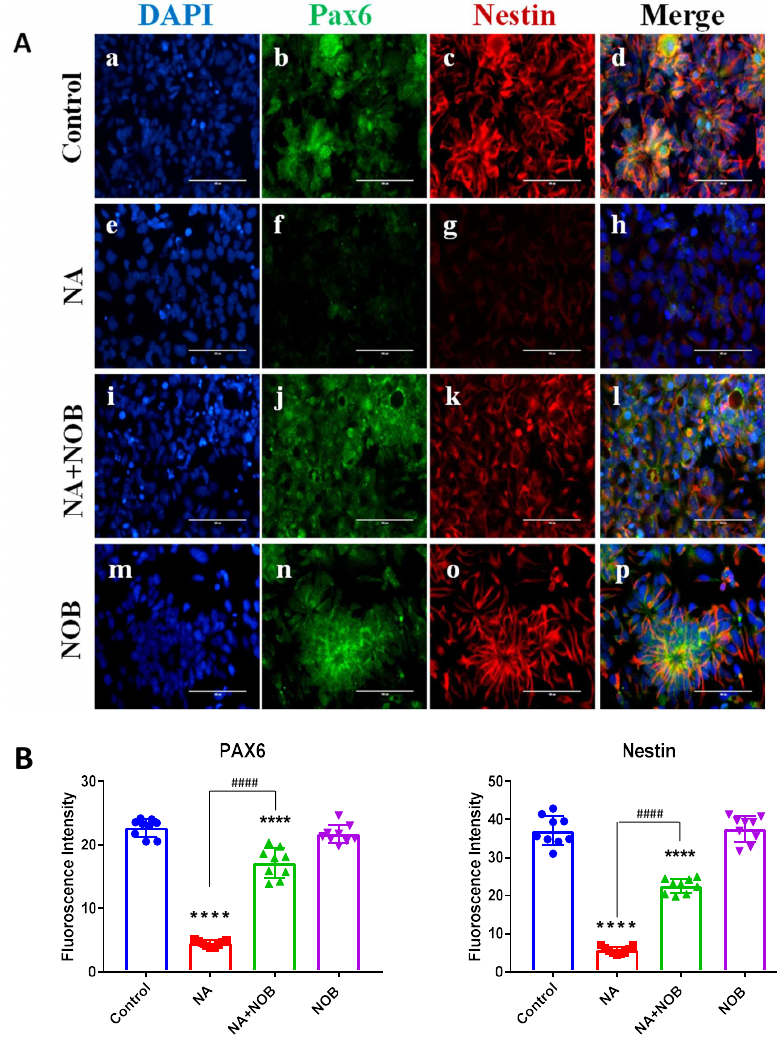
Figure 5. Effect of NA and NOB on hNPCs neuronal markers. ( A ) Representative immunocytochemistry (ICC) images of hNPCs depicting the expression of functional neuronal marker genes PAX6 and nestin of ( d ) Control or unexposed cells, ( h ) NA-exposed cells, ( l ) NA and NOB co-exposed group, ( p ) NOB-exposed cells; Images were taken using an Invitrogen EVOS FL fluorescence microscope. Scale bar, 100 µ M. ( B ) Fluorescent intensity was calculated by ImageJ software, and images are represented in graph format. Data are presented as the ± SEM of three separate experiments performed in n = 3 (biological replicates). The change in expression pattern is statistically significant as indicated by **** p < 0.0001 vs. the control and #### p < 0.0001 compared with NA-exposed cells. We also confirmed the expression of Tuj1 and MAP2 via immunocytochemistry tech-